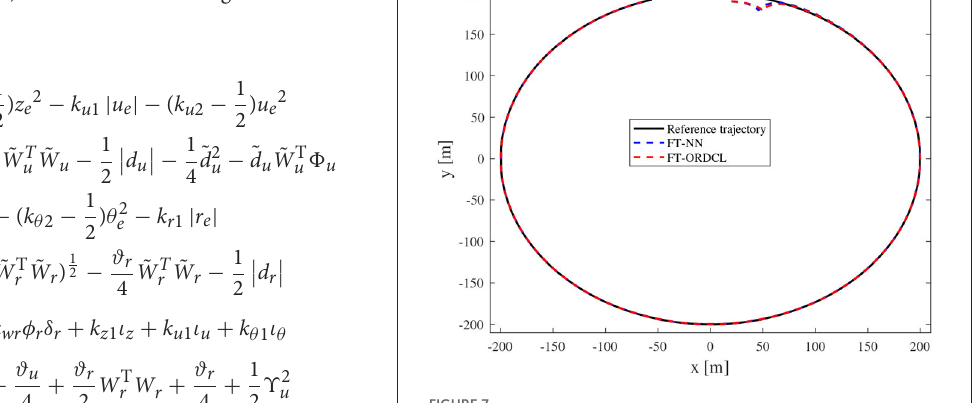
FIGURE7 Reference and actual trajectories of the MSV in Case 2.